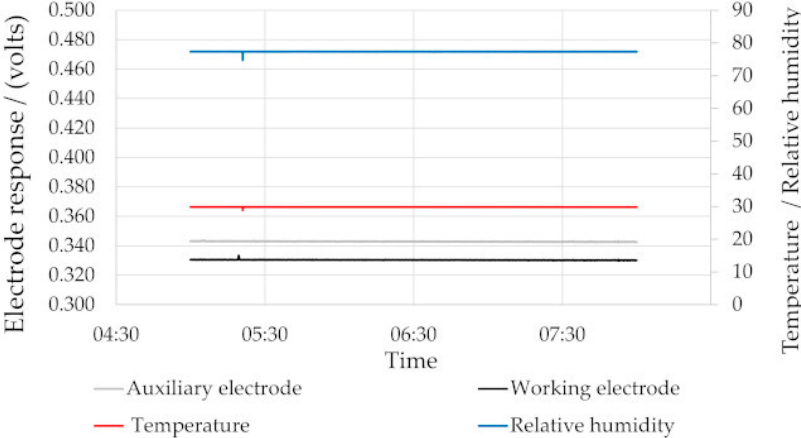
Figure 2. Stable electrochemical responses under isothermal/isohume conditions.